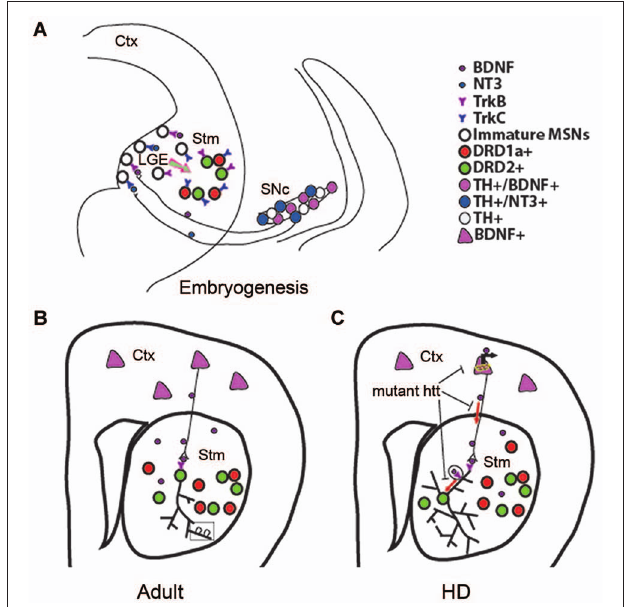
FIGURE 2 | Role of BDNF in developing, adult, and HD striatum. (A) A proposed model showing that BDNF and NT3 anterogradely transported from mesencephalic dopaminergic neurons regulate survival of immature neurons in the indirect and direct pathways, respectively. Ctx, cerebral cortex; Stm, striatum; SN, substantia nigra. (B) Cortical BDNF in the adult striatum mediates dendritic complexity and spine number and morphology. (C) Mutant htt reduces BDNF-TrkB signaling by inhibiting BDNF gene transcription, axonal transport of vesicles containing BDNF, retrograde dendritic transport of TrkB-positive endosomes to the cell body. Panel A is adapted from Baydyuk et al.